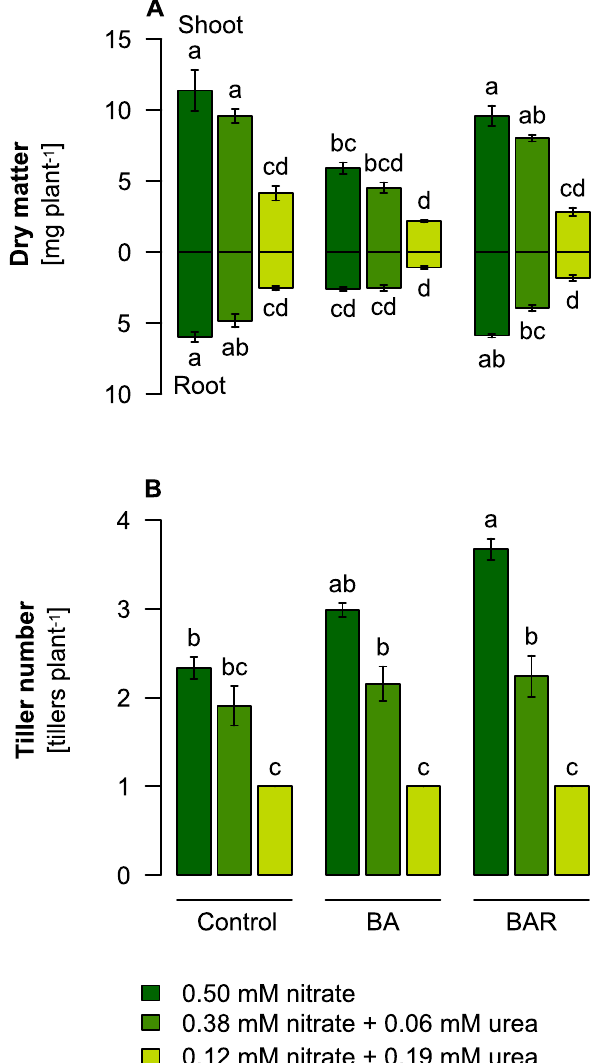
Figure 2. Growth and tiller formation in barley after external supplementation of cytokinins in the presence of nitrate or urea. ( A ) Dry weight of shoots and roots and ( B ) tiller number of spring barley plants precultured hydroponically on ammonium nitrate before transfer to different N sources: 0.5 mM KNO 3 , 0.38 mM KNO 3 + 0.06 mM urea (75:25% N), or 0.12 mM KNO 3 + 0.19 mM urea (25:75% N). The pH was buffered at pH 6.6 by Ca(HCO 3 ) 2 . The cytokinin analogue 6-benzylaminopurine (BA) was supplied at a concentration of 10 µM at the beginning of tillering (3-leaf stage). Tillers were counted at the 7-leaf stage. The urease inhibitor PPD was supplemented at 75 µg L −1 . Bars represent means ± SD, n = 20 biological replicates. Different letters indicate significant differences among treatments at p < 0.05 by Tukey’s